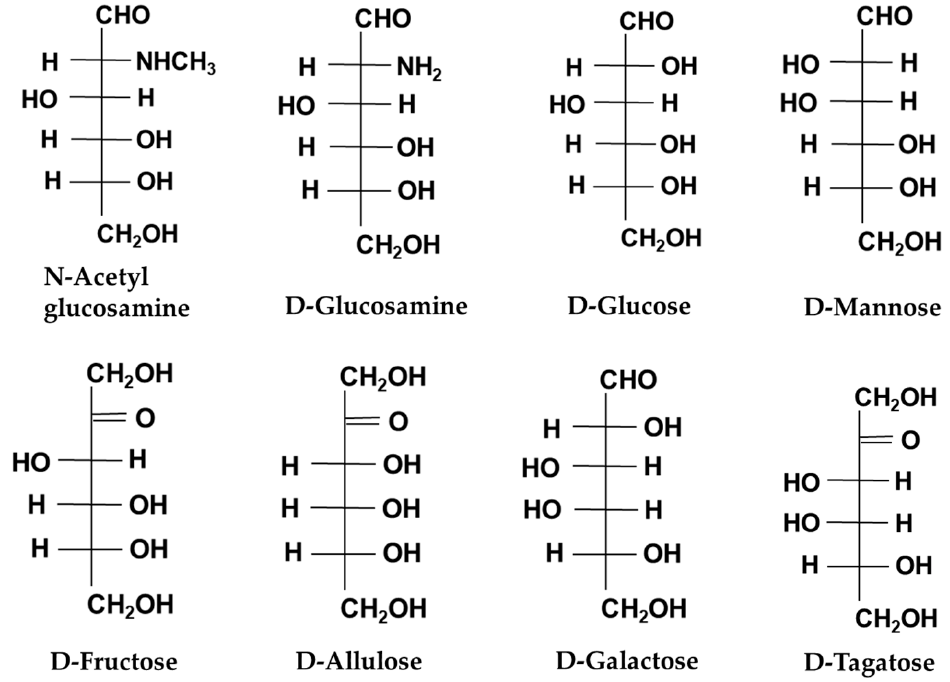
Figure 2. D -Hexoses in the food industry.